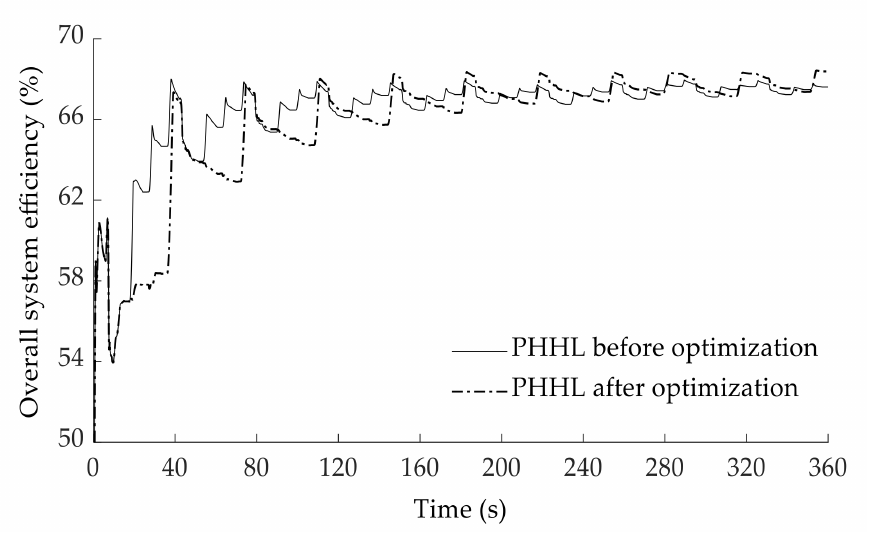
Figure 20. Overall transmission system